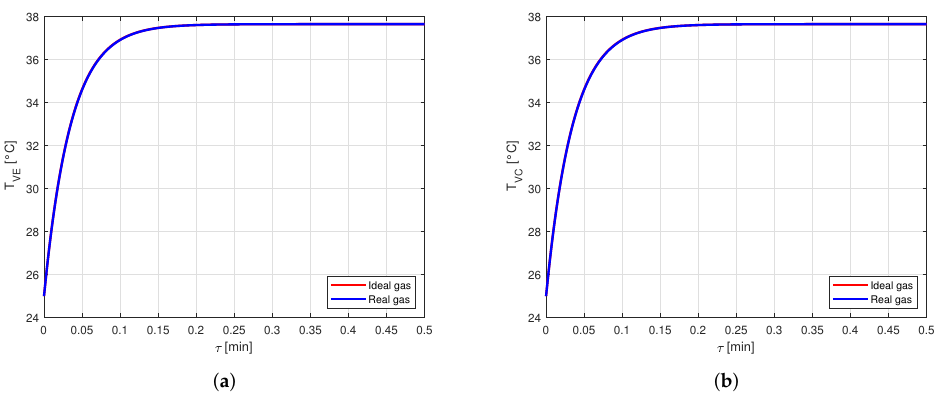
Figure 11. Comparison between the vapor temperatures obtained by modeling the vapor as ideal or real gas, in an aluminum-ammonia heat pipe. ( a ) Comparison of the vapor temperatures at the evaporator. ( b ) Comparison of the vapor temperatures at the condenser.